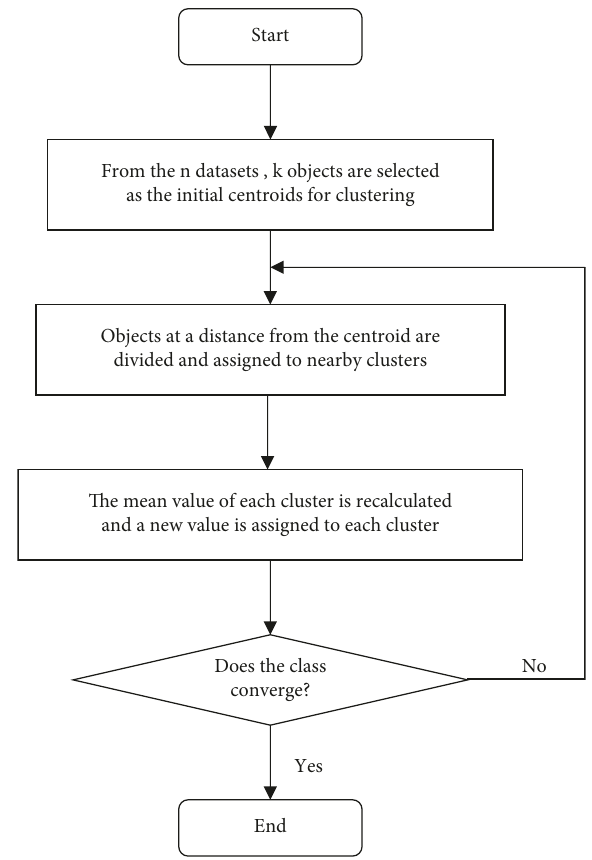
Figure 4: Detailed process of the K-medoids algorithm.